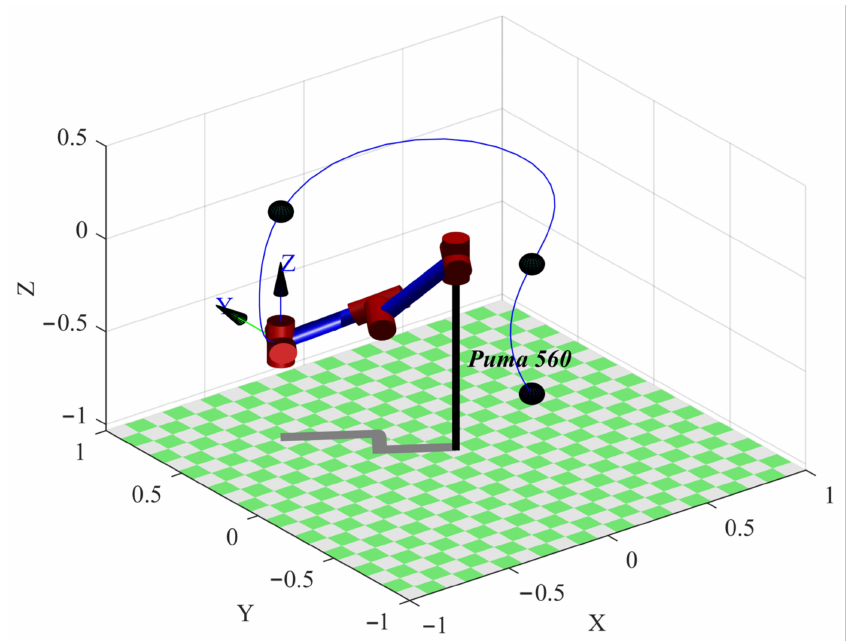
Figure 10. The end‑effector trajectory under the optimal time in Cartesian